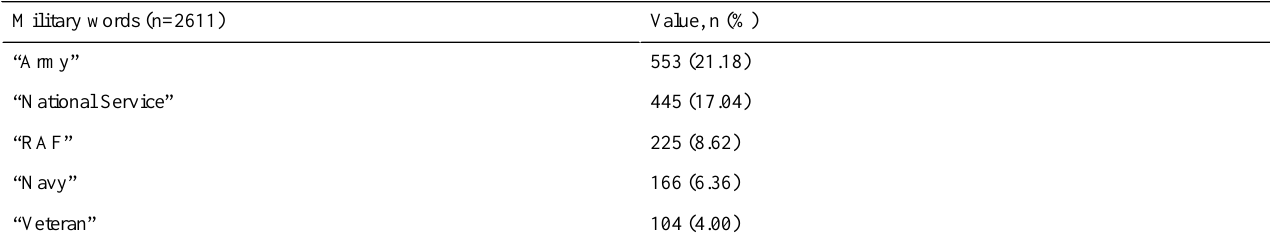
Table 3. Top 5 occurring military words identified during manual annotation of the gold standard training dataset.